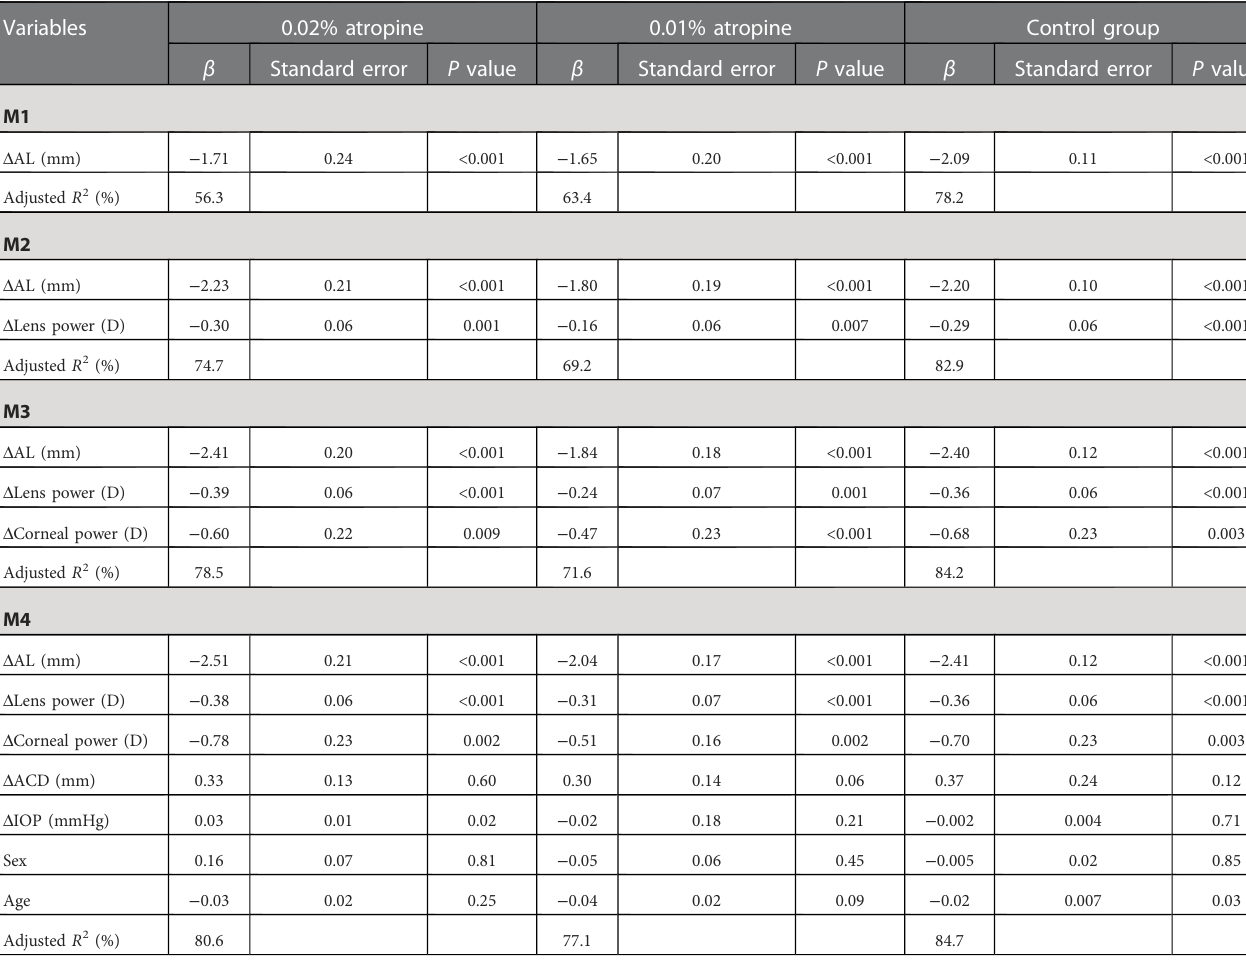
TABLE 3 Multivariate linear regression analyses of change in spherical equivalent refractive error and ocular